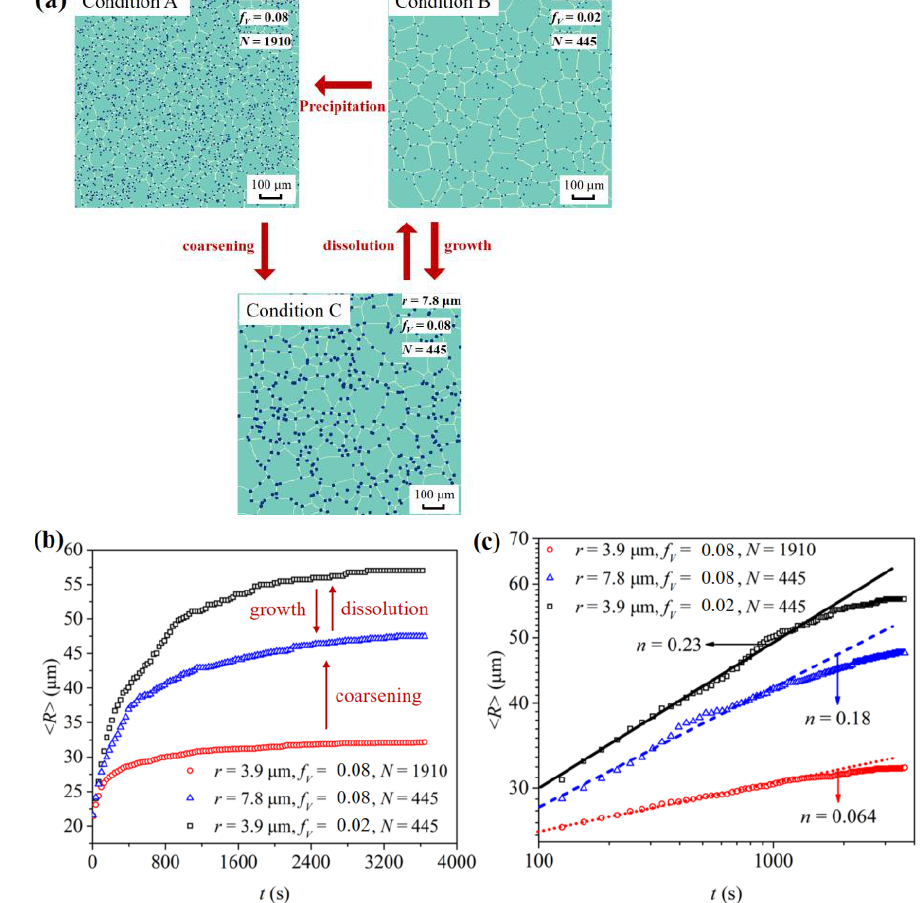
Figure 2. Simulation conditions and simulation results of the grain coarsening kinetics. ( a ) Simulation conditions and the corresponding stagnating microstructures. ( b ) Relationships between the grain radii and coarsening time for different conditions. ( c ) Logarithmic relationships between the grain radii and coarsening time.